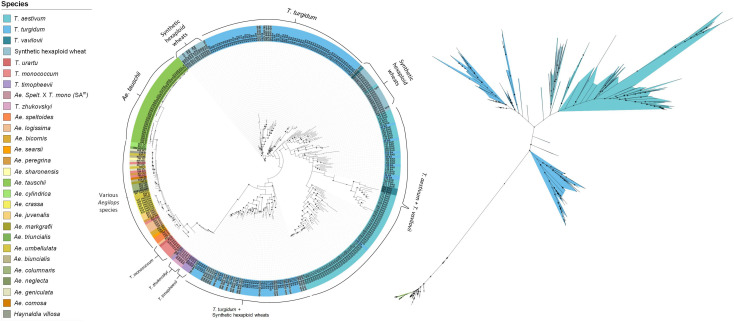
Rooted (left) and unrooted (right) phylogenetic trees illustrating the relationships between species. The tree was generated using the maximum likelihood approach with 1,000 bootstrap iterations. The size of the internal node symbols reflects the bootstrap confidence level and the leaf node labels correspond to the identification number and genome of each accession. The species are color-coded as indicated in the legend.